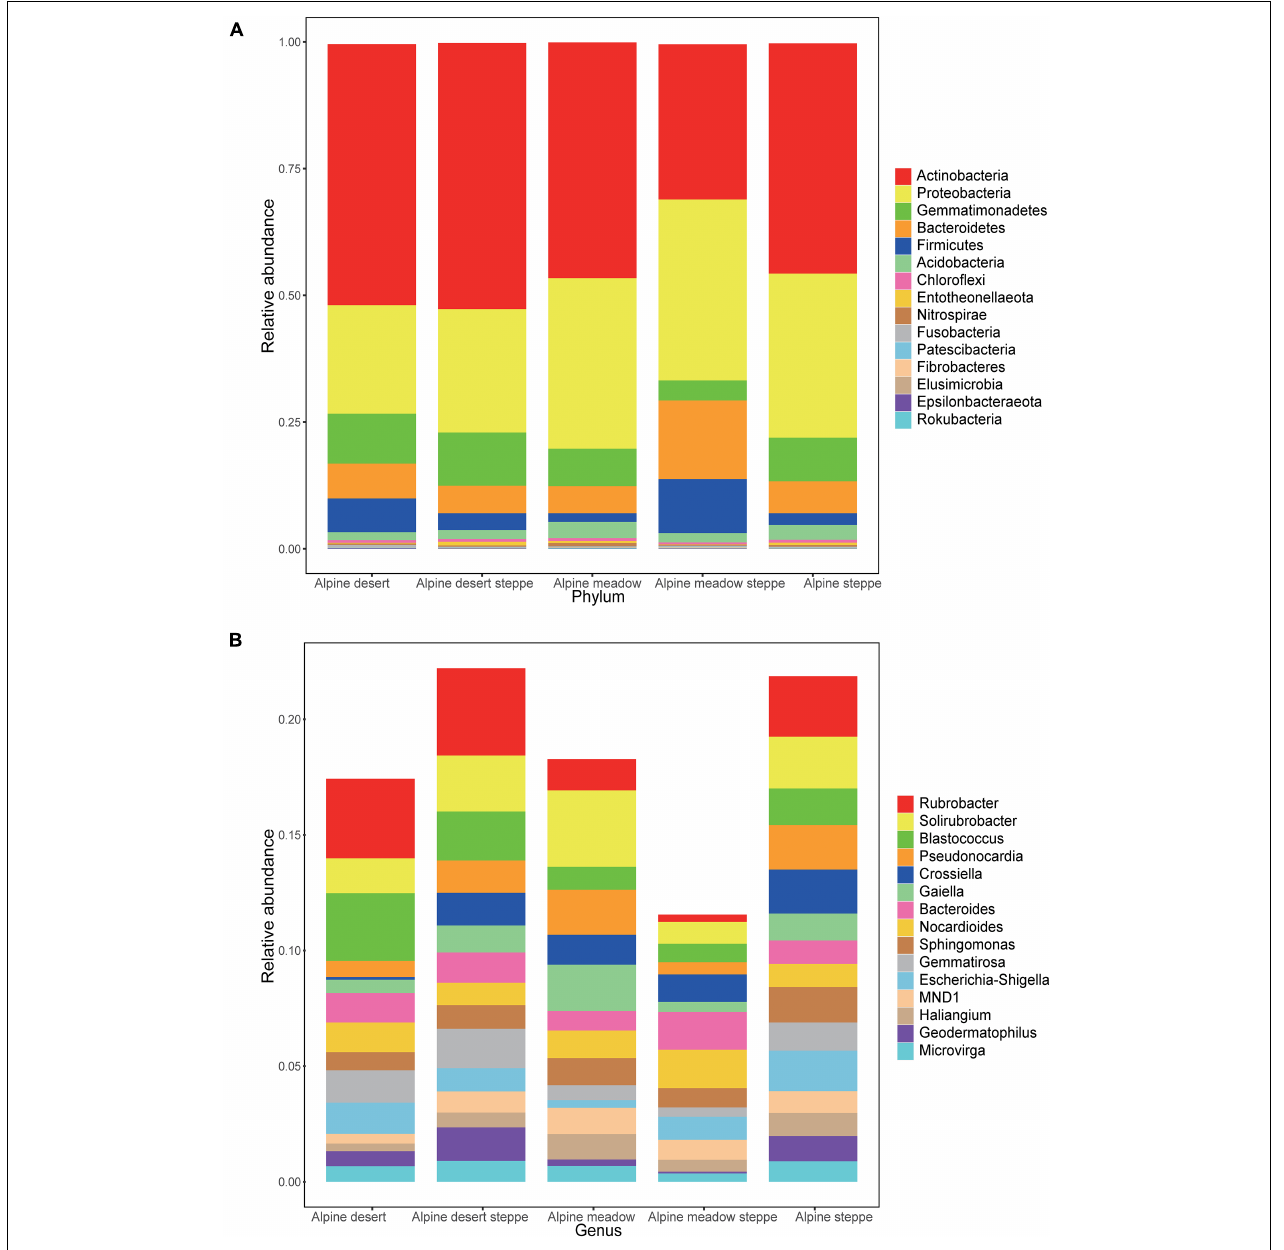
FIGURE 2 | Relative abundance of bacteria in different grasslands at the phylum and genus levels on the Tibetan Plateau. The bacteria whose relative abundance are in the top 15 at phylum (A) and genus (B) levels. AD, alpine desert; ADS, alpine desert steppe; AM, alpine meadow; AMS, alpine meadow steppe; AS, alpine